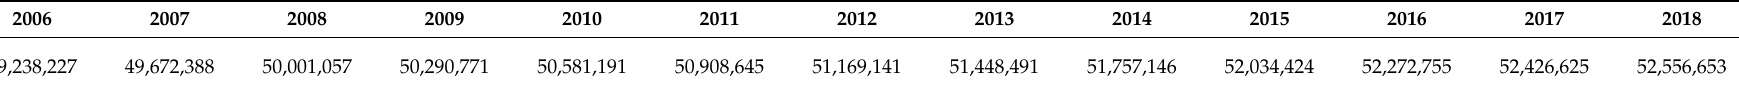
Table 1. Actual numbers and prevalence of thalassemia in the Korean population